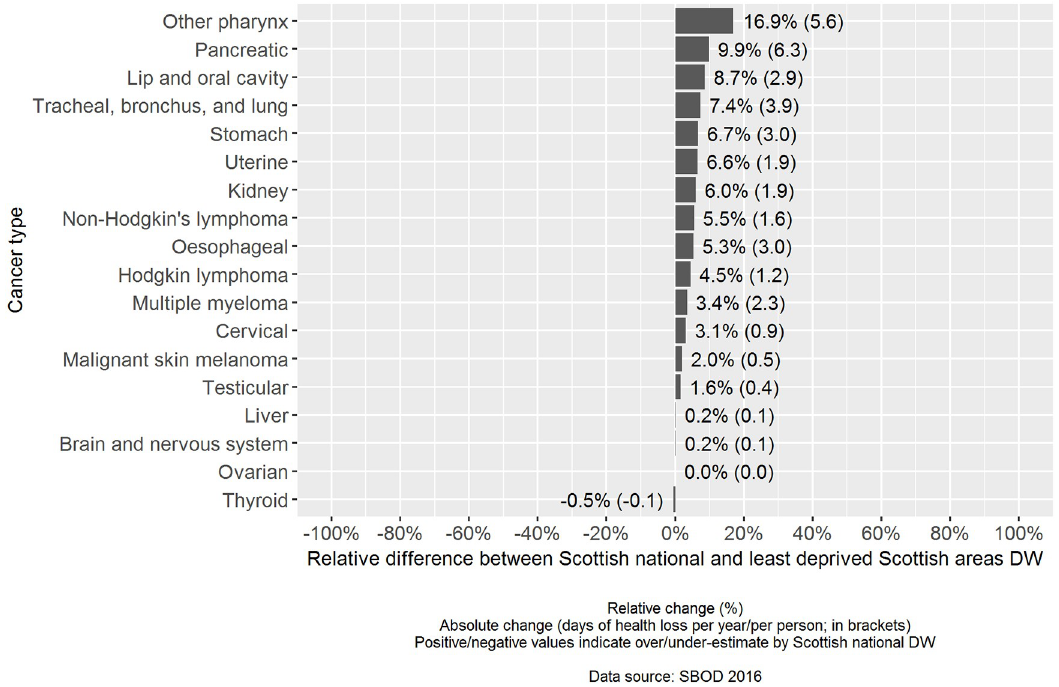
Fig 3. Relative and absolute comparison of cancer disability weights: Scottish national versus least deprived fifth of Scottish areas.